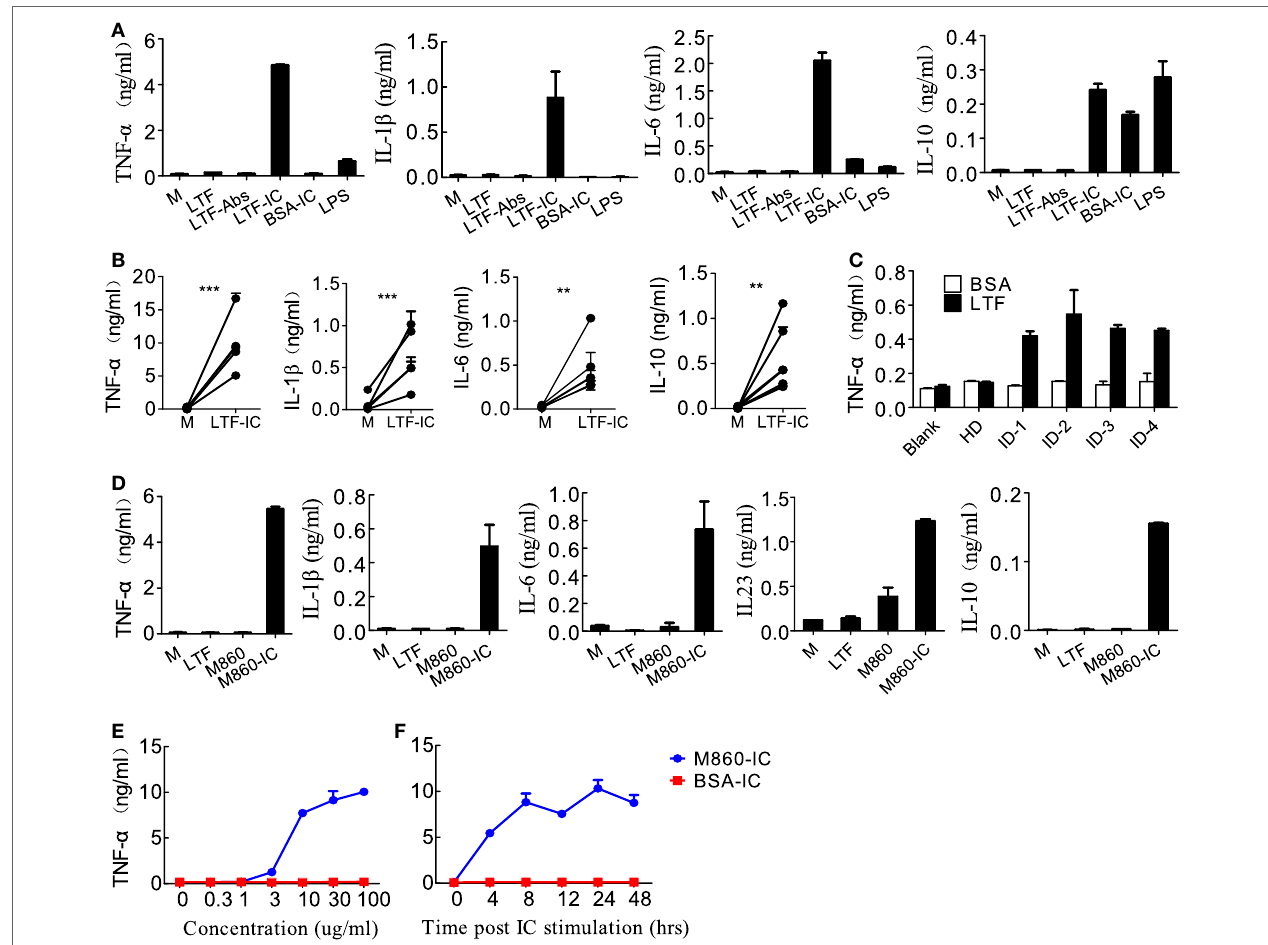
FigUre 1 | Lactoferrin-containing IgG immunocomplex (LTF-IC) induced proinflammatory cytokines production by human (M-CSF)-M2 macrophages. (a) Freshly differentiated (M-CSF)-M2 macrophages (5 × 10 4 cells/well) were stimulated with 30 µg/ml human LTF (hLTF), LTF-Abs, LTF-IC, bovine serum albumin (BSA)-IC, or 100 ng/ml lipopolysaccharide(LPS) for 18 h, followed by quantitation of TNF α , IL-1 β , IL-6 and IL-10 in culture supernatant using ELISAs. (b) (M-CSF)-M2 macrophages differentiated from different donors ( n = 5) were treated with, or without (M), LTF-IC for 18 h, followed by cytokine quantitation using ELISAs. Each pair of dots represents one donor. ** P < 0.01. *** P < 0.001. (c) Serum samples (diluted 1:100 in PBS) from healthy donors (HDs) or four rheumatoid arthritis patients with high titer LTF-specific autoantibodies were dispensed into 96-well cell culture plates precoated with, or without, hLTF and incubated for 2 h. (M-CSF)-M2 macrophages were then added to the wells and incubated for 18 h, followed by quantitation of TNF α in culture supernatant by ELISAs. (D) (M-CSF)-M2 macrophages were cocultured with 30 µg/ml hLTF, M860 or M860-IC for 18 h followed by quantitation of TNF α , IL-1 β , IL-6, IL-23, and IL-10 in culture supernatant using ELISAs. (e) (M-CSF)-M2 macrophages were stimulated with increasing concentrations of M860-IC or BSA-IC (0–100 µg/ml) for 18 h followed by ELISA quantitation of TNF α in culture supernatant. (F) Time course of (M-CSF)-M2 macrophage response to stimulation of 30 µg/ml M860-IC or BSA-IC in terms of TNF α production. The data are expressed as mean ± SD performed in parallel and representative of at least three experiments with different